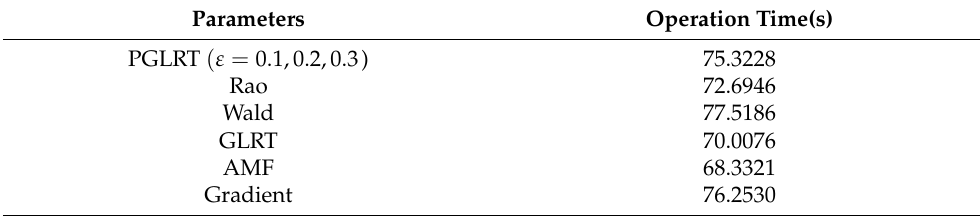
Table 1. Computation complexity of the detectors.